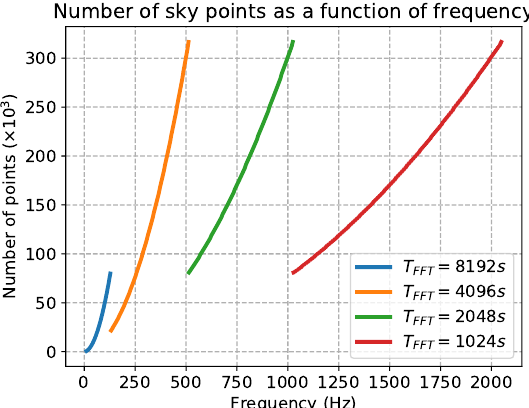
Figure 4. Plots of the number of points in the sky grid generated for the FrequencyHough search, as a function of